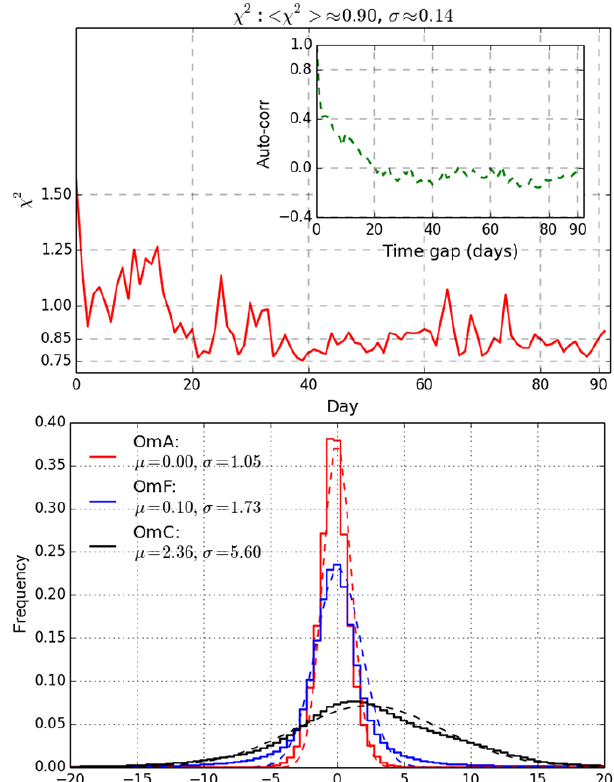
Figure 6. Self-consistency tests. Top panel: time series (red line) of χ 2 for OmF and its associated autocorrelation signal (green line). For the χ 2 diagnostic, we normalize the OmF differences by the background error. The labels show time in days ( x axis) and χ 2 value ( y axis) for the χ 2 plot and time gap in days ( x axis) and au- tocorrelation ( y axis) for the autocorrelation plot. Bottom panel: his- tograms of observations minus analysis (OmA – red solid line), ob- servations minus forecast (OmF – blue solid line), and observations minus control run (OmC – black solid line). We normalize these differences by the observation error. The dashed lines correspond to the Gaussian fits of the different histograms. The labels show the OmA, OmF, or OmC differences ( x axis) and the frequency of oc- currence of the differences ( y axis). We calculate the diagnostics OmA, OmF, and OmC over the period of 1 June–31 August